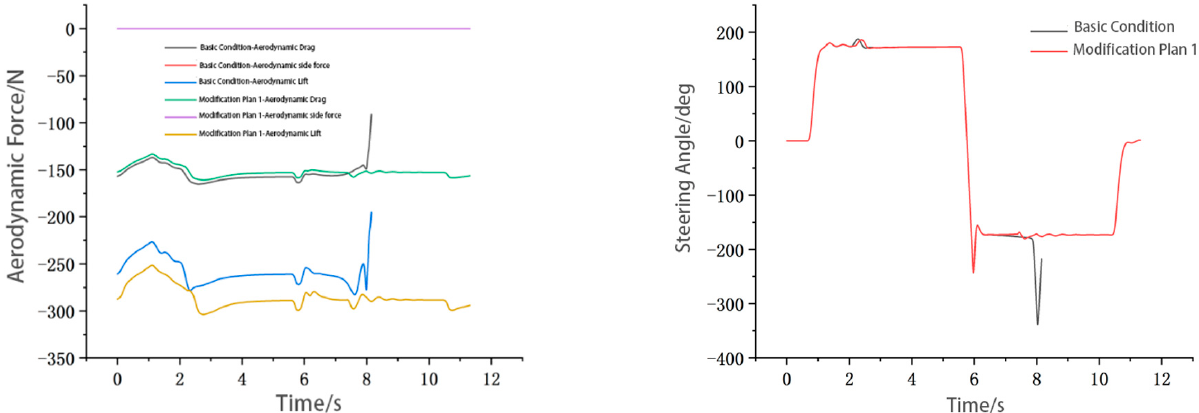
Figure 23. Comparison curve of aerodynamic force and steering–wheel angle in figure-eight sur- round simulation.